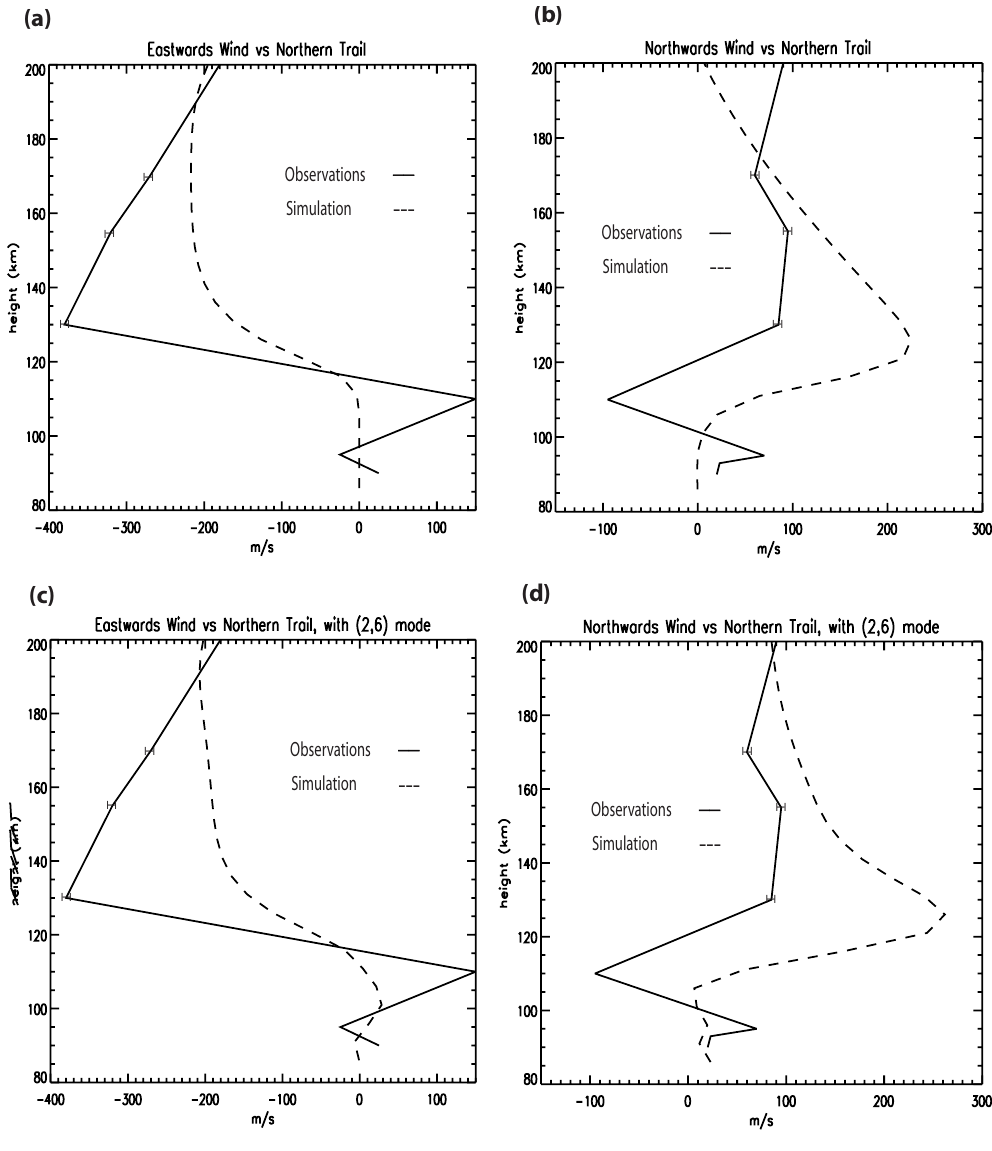
Fig. 5. As Fig. 4, but for northern trail